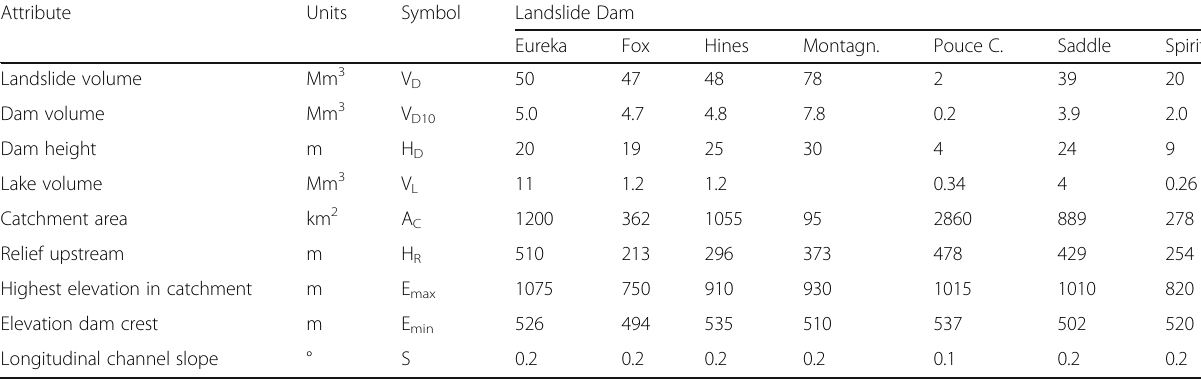
Table 4 Morphometric parameters of the Peace River regional landslide dams Attribute